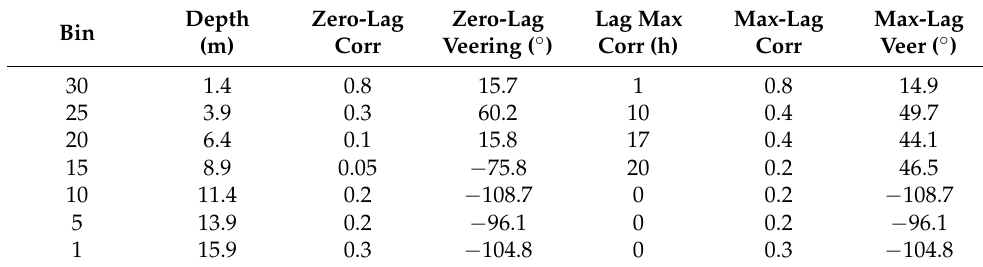
Table 8. Lagged vector correlation between low-passed wind stress and low-passed currents. Am- plitude and angular offset of lagged correlation between low-passed wind stress and observed low-passed